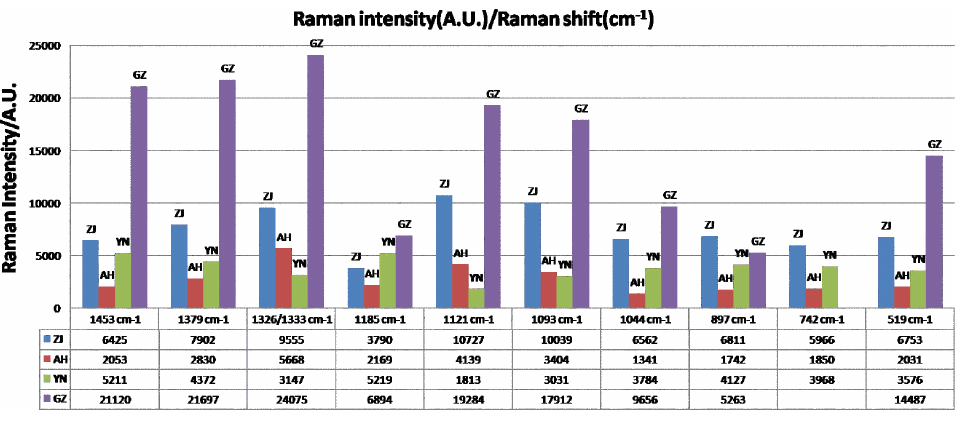
Figure 5 The variation of identified peak intensity for different dendrobiums. Full-size DOI: